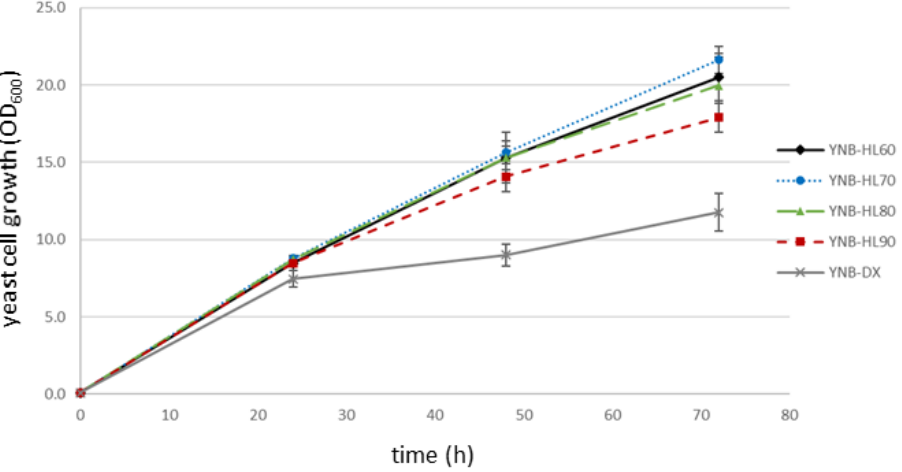
Figure 4. Growth of I. orientalis KJ27-7 in WSHL. OD 600 of I. orientalis KJ27-7 in control media with 20 g L −1 glucose and 20 g L −1 xylose (x, YNB-DX), or in YNB media with 60% ( υ , YNB-HL60), 70% ( λ , YNB-HL70), 80% ( π , YNB-HL80), or 90% ( ν , YNB-HL90) WSHL as sole carbon source after 24, 48 and 72 h at 26 °C. Displayed are mean values ± SD of four independent experiments each performed in duplicates.